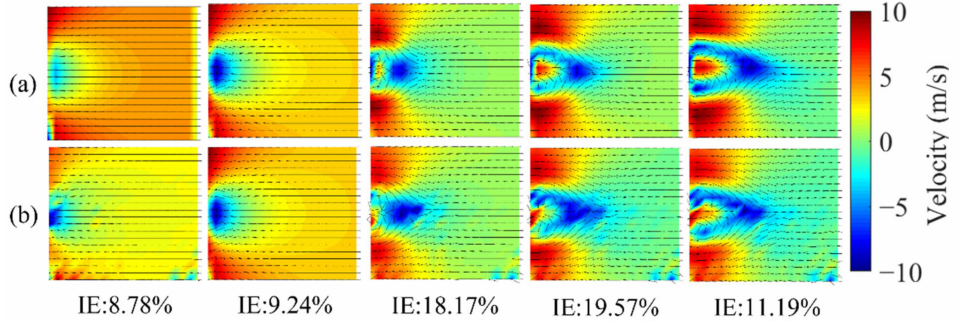
Figure 12. The original wind field ( a ) and the corresponding retrieved wind field ( b ); the arrows represent the direction of the wind and the colours indicate its